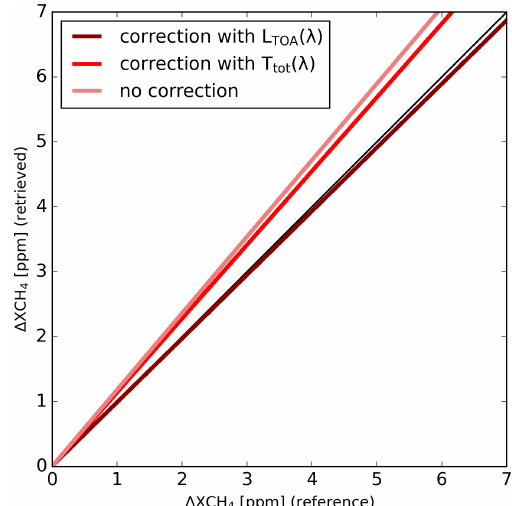
Figure 5. Linear regression of retrieved pixel values versus refer- ence methane enhancement for the Korpeje site (see Fig. 2a), plume 2 (see Fig. 3b) and Q of 5000kgh − 1 . The reference acquisition is the same as the target one with no excess methane to simulate an ideal